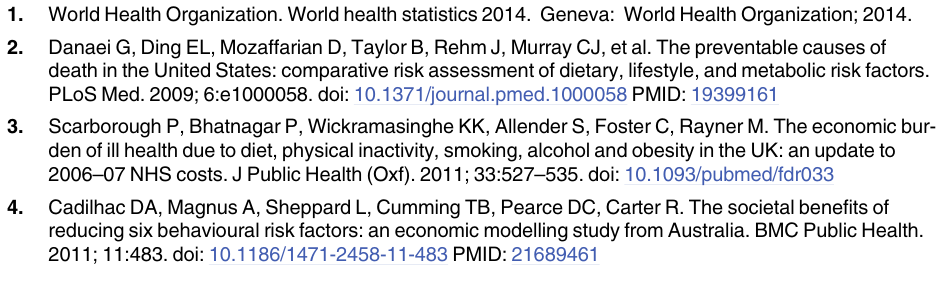
S1 Table. Comparison of participants with a lifestyle risk index score and included in the analysis versus those with a missing score (New South Wales, Australia, n = 264,847). S2 Table. Sensitivity analysis: prevalence of all 96 combinations of lifestyle risk behaviors and adjusted hazard ratios for their associations with all-cause mortality after excluding deaths within the first 2 y (2006 – 2014, n =